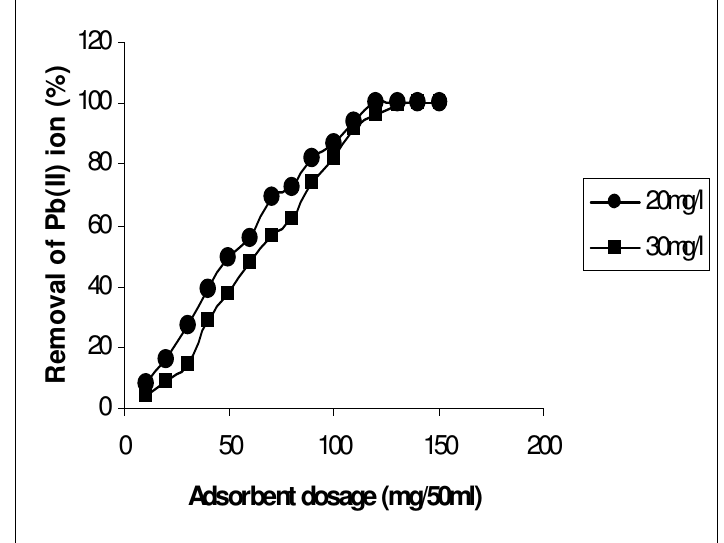
Figure 4 . Effect of SCHC dosage on the adsorption of Pb(II)